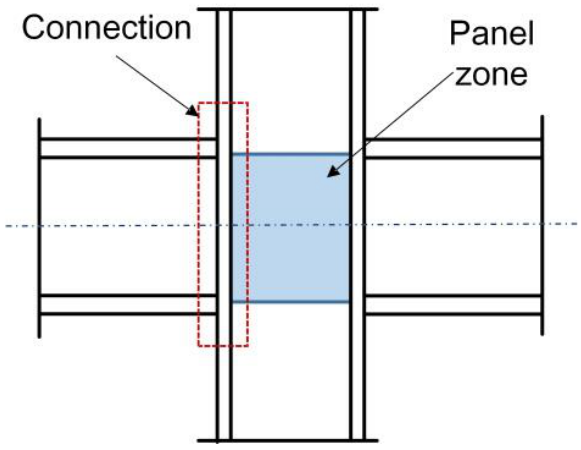
Figure 13. Joint (connection + web panel).